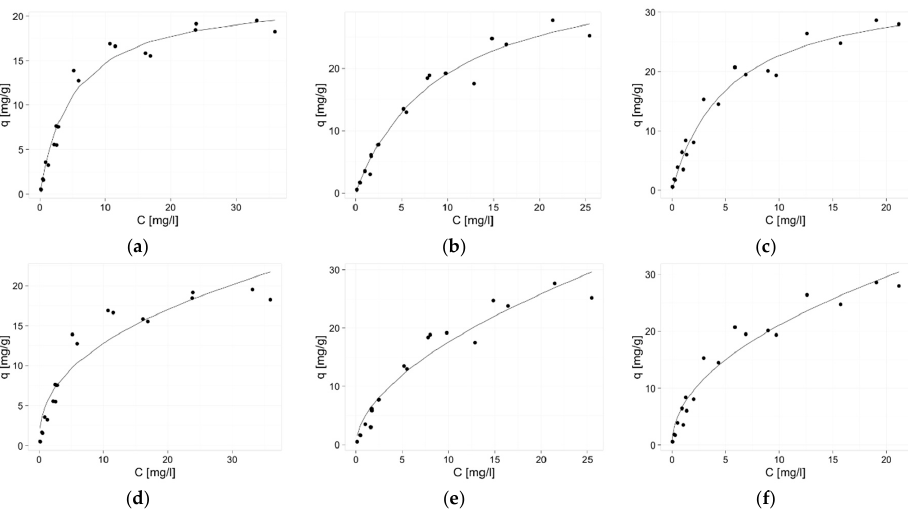
Figure 3. Sorption isotherms of zinc on pectin-based biosorbents. Langmuir model: ( a ) hybrid pectin biosorbent with agar (P + A); ( b ) hybrid pectin biosorbent with guar gum (P + G); ( c ) sole pectin biosorbent (P) and Freundlich model; ( d ) hybrid pectin biosorbent with agar (P + A); ( e ) hybrid pectin biosorbent with guar gum (P + G); ( f ) sole pectin biosorbent (P). Mass of sorbent 0.03 g, volume of Table 3. The reported zinc ion sorption capacities of various biosorbents. Sorbent Sorption Capacity (mg/g) Reference